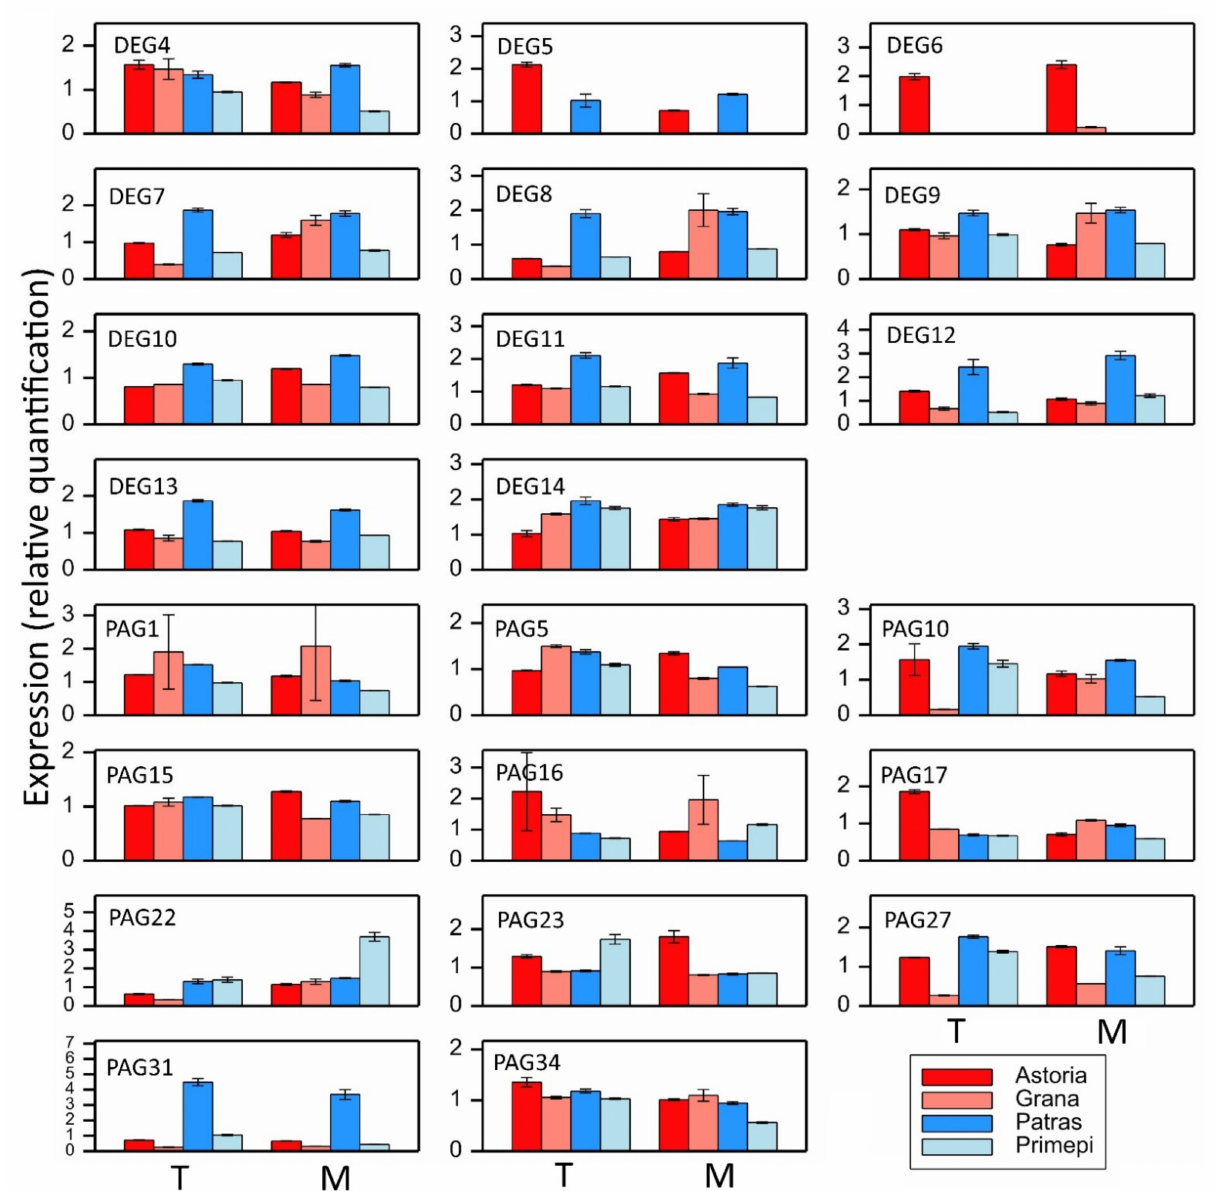
Figure 6. Expression profiles of selected DEGs and PAGs as determined by qRT-PCR. Data are presented as relative quantification with standard error